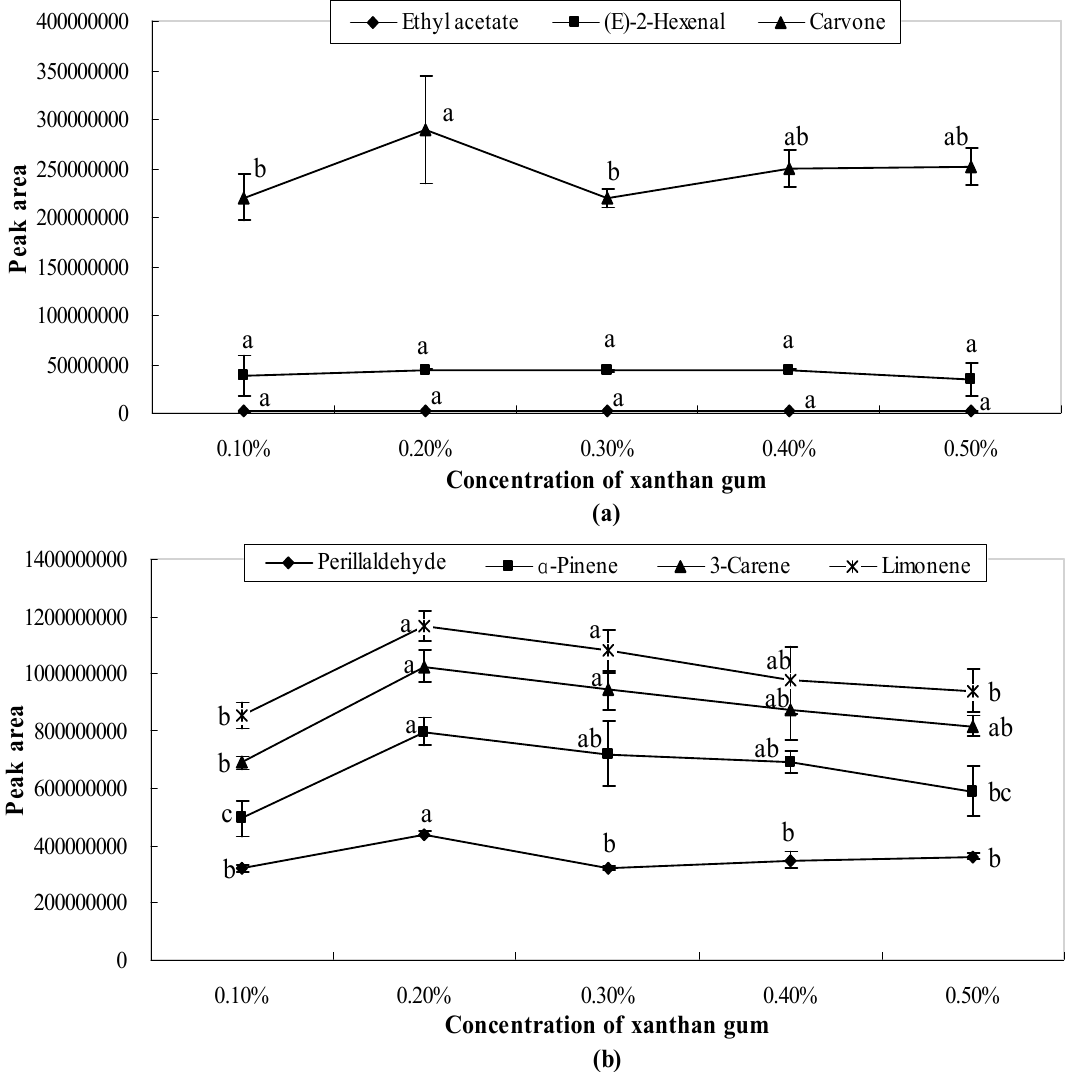
Figure 4. Effects of xanthan gum on the release of ethyl acetate, ( E )-2-hexenal, carvone ( a ) and perillaldehyde, α -pinene, 3-carene, limonene ( b ). Significant differences ( p < 0.05) between different concentrations are performed by letters on the same polylines. Where the letters on the same polyline are the same, there is no significant difference between different concentrations.